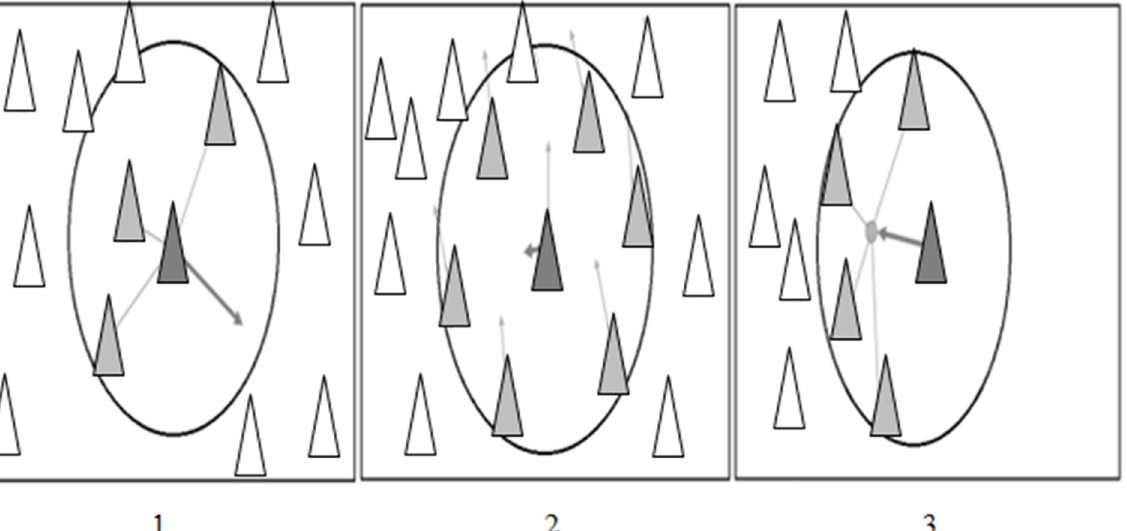
Fig 3. PSO Basic Behaviors. Figure 3.1 shows separation behavior where particle avoiding other particles. Figure 3.2 shows alignment behavior where particle moving towards head of local flockmates and maintain the speed between them. Figure 3.2 shows cohesion behavior where particle moving towards the average position of local flockmates